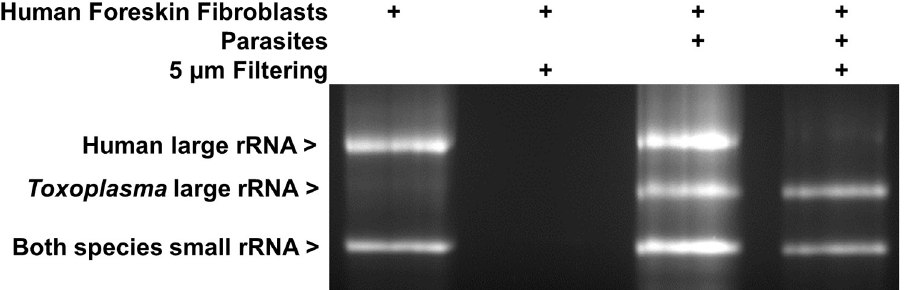
Fig 2. Filtering reduces host RNA. T25 flasks with HFFs (human foreskin fibroblasts) were infected with tachyzoites or left uninfected. Contents of a flask were scraped, passed through a 27 g needle three times, and half was then passed through a 5 μ m filter to remove host material, the other half being kept for comparison. RNA was extracted from all samples using TRIzol and analyzed by agarose gel electrophoresis with visualization using ethidium bromide staining. Bands corresponding to the human and Toxoplasma large and small subunit rRNAs are